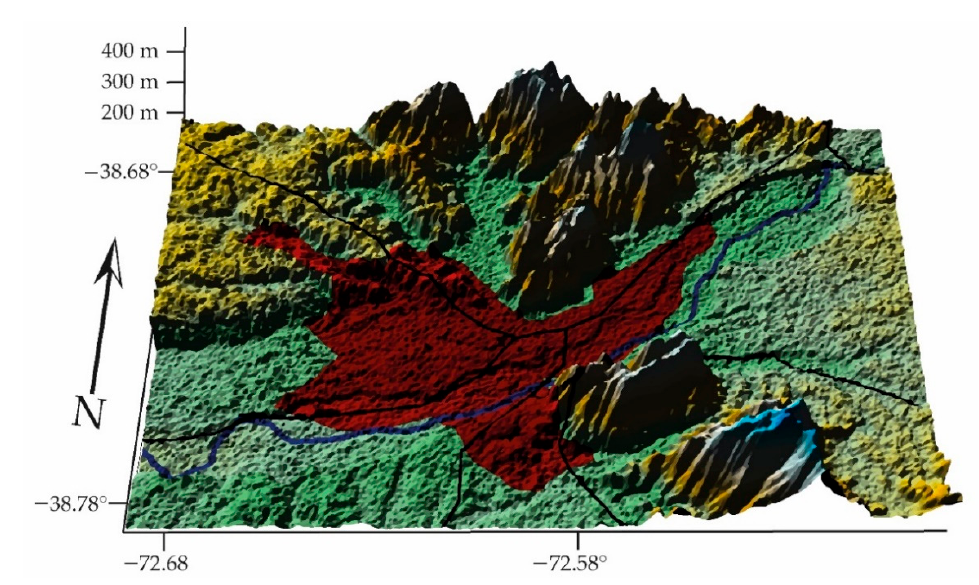
Figure 12. C K, Las Encinas Stat = 0.97, the entropy of the contaminants is more dominant (GCS, WGS84). (e) Entre Lagos station is located in the city of Osorno, 60.9 away from Bah í a Mansa, access to the Pacific Ocean. It is located in the intermediate depression, between the Cordillera de los Andes (highest peak, Osorno volcano, 2660 masl) and the Cordillera of the Coast, low and undulating in the north, more robust in the south, exerting an effect of climatic screen in the intermediate depression (La Uni ó n, Osorno and R í o Negro) (Figure